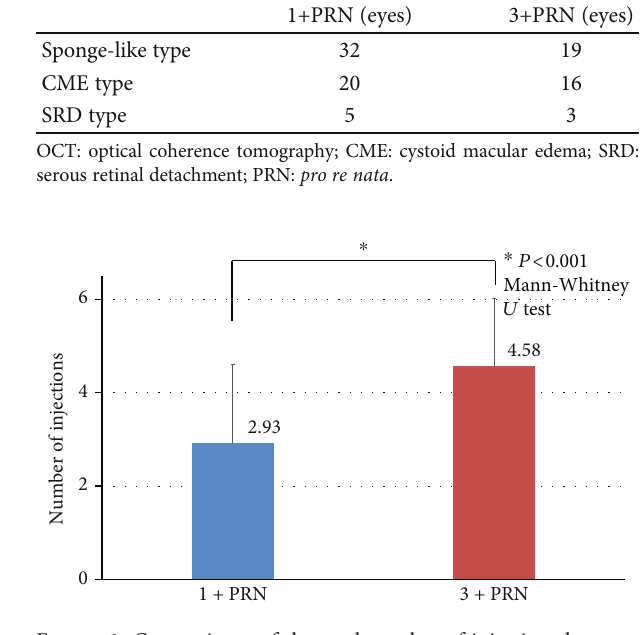
Figure 1: Comparisons of the total number of injections between the 1+PRN and 3+PRN groups at 12 months. The mean total number of injections in the 3+PRN group was 4 : 6 ± 1 : 4 , which was signi fi cantly more than 2 : 9 ± 1 : 7 in the 1+PRN group